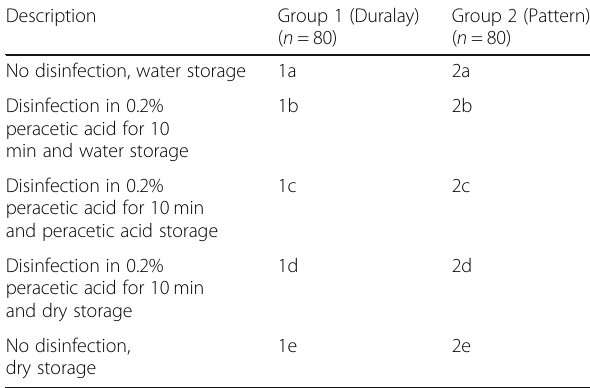
Fig. 3 Horizontal dimension considering the length between the most distal prosthetic surfaces of the